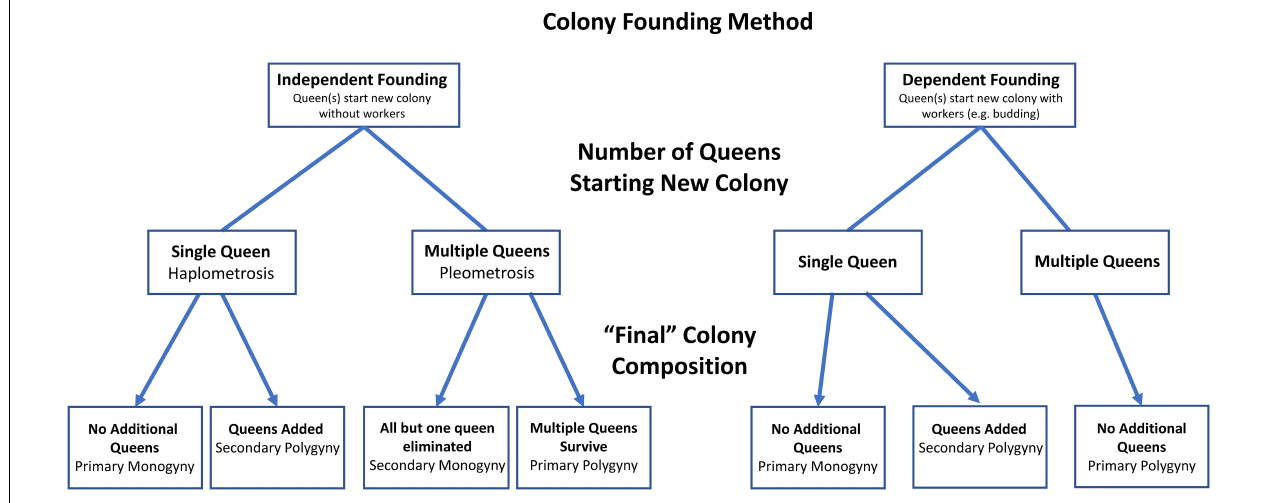
FIGURE 2 | Mechanisms leading to variation in colony-queen number in ants over time. Non-kin queen associations occur when alates from different nests come together to start new colonies (pleometrosis through independent colony founding) or when unrelated queens are adopted into existing colonies (secondary polygyny). Modified from Hölldobler and Wilson